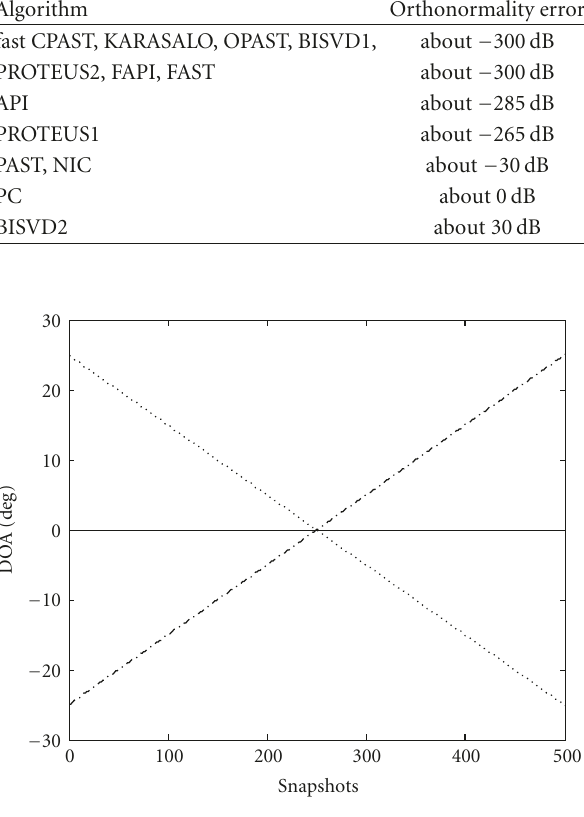
Figure 10: Real trajectories of three crossing-over targets versus number of